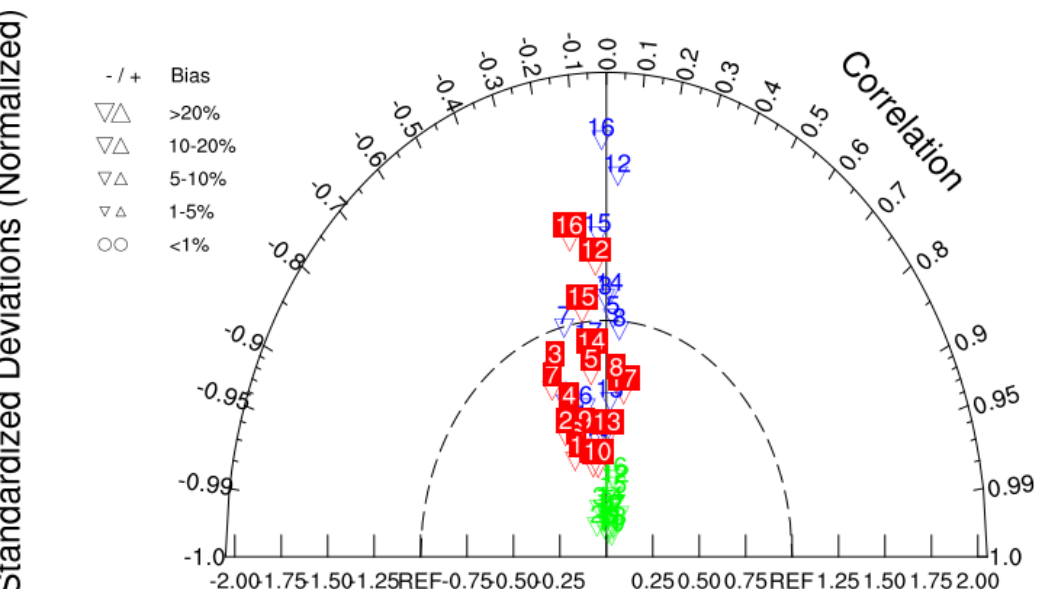
Figure 3. Taylor diagram for the 1060–2016 precipitation and climate drivers (ENSO-blue, PDO-red, AMO-green). Southern Mexico is represented by the points 1–5, Central America by the points 6–12, and the Caribbean by 13–17.